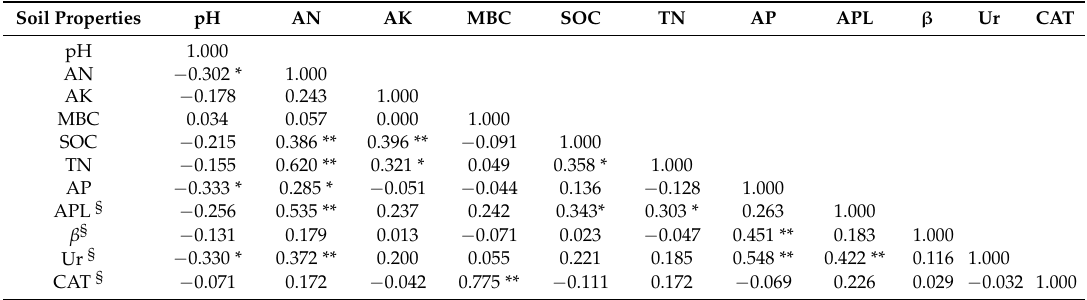
Table 4. The Pearson correlation coefficients between soil properties and enzyme